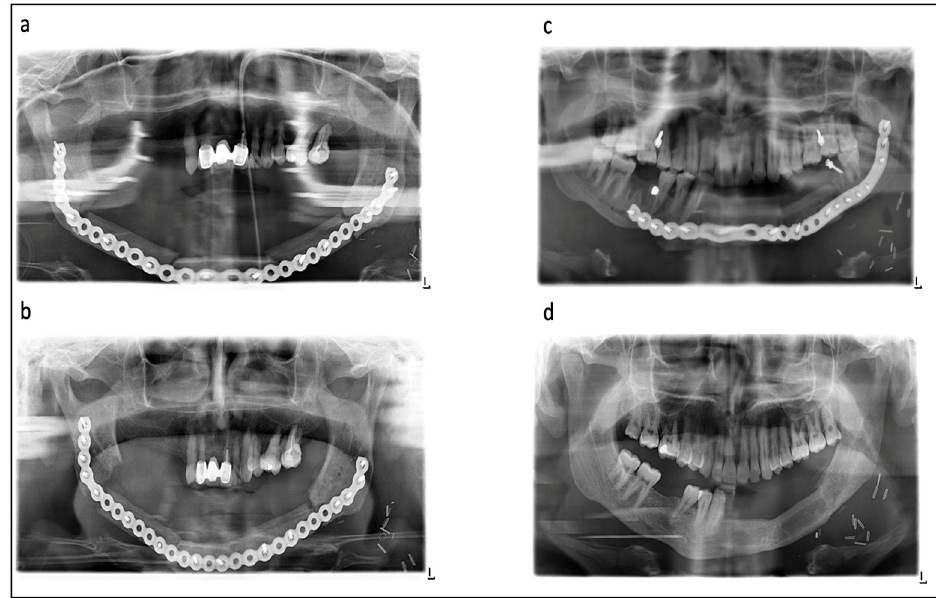
Figure 1. Various examples for ossification in different radiographs: ( a ) and ( b ) show patient after preoperative radiotherapy, consecutive osteoradionecrosis of the mandible and reconstruction with a 3-segmented fibula. ( a ) Initial postsurgical radiograph with good contact between fibular segments in left canine area, moderate contact in right canine and right angle area and no contact in left angle area. ( b ) After 6 months, complete intersegmental ossification and nonossification between segments and original bone. ( c ) and ( d ) show young patient after gunshot wound and reconstruction with a two-segmental fibula. ( c ) Initial postsurgical radiograph with good contact between fibula segments and graft/native bone. ( d ) After 1 year, complete ossification of all contacts allowed for removal of the reconstruction plate.